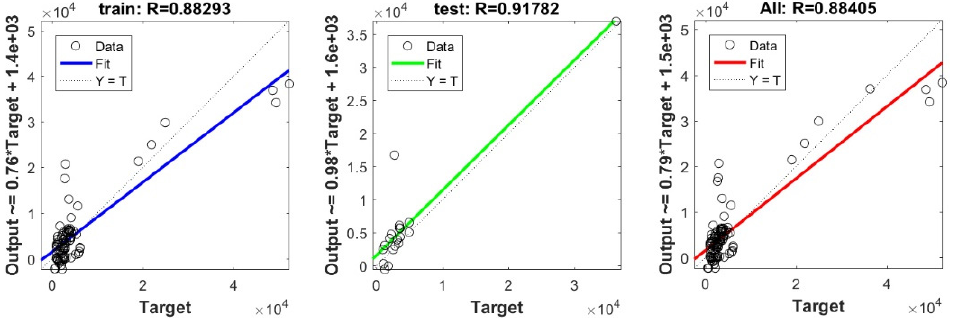
Figure A3. Scatter plots between target and output values by the ELM model.